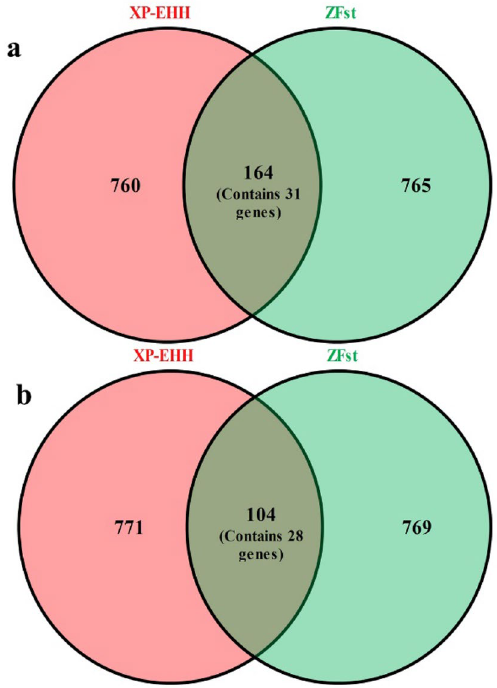
Figure 4. Venn diagram showing the overlapped genomic windows between the top 1% percentile of ZFst and XP-EHH distributions in ID ( a ) and IB ( b )